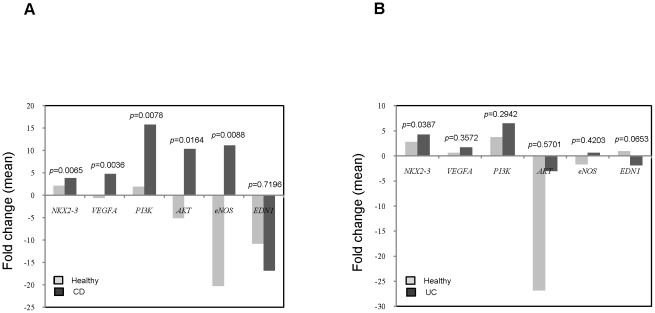
mRNA expression levels of 6 genes in intestinal tissues from CD and UC patients.(A) Comparison of mRNA expression levels of 6 genes in diseased vs. adjacent normal intestinal tissues from CD patients: NKX2-3 (n = 30), VEGFA (n = 30), PI3K (n = 31), AKT (n = 28), eNOS (n = 24), and EDN1 (n = 30). RT-PCR was carried out on surgically excised diseased and adjacent normal intestinal tissues from CD patients. The RT-PCR product bands on the photograph were scanned by densitometry. RT-PCR results were normalized by GAPDH as fold change for each patient. Data are presented as the means. (B) Comparison of mRNA expression levels of 6 genes in diseased vs. adjacent normal intestinal tissues from UC patients: NKX2-3 (n = 30), VEGFA (n = 32), PI3K (n = 32), AKT (n = 21), eNOS (n = 23), and EDN1 (n = 27). RT-PCR was carried out on surgically excised diseased and adjacent normal intestinal tissues from UC patients. Data are presented as the means.